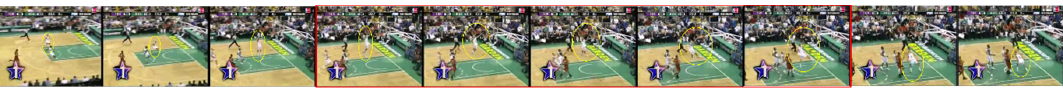
Figure 2. The change in frames in a “basketball dunk” over time. The yellow circles mark the changes in action, and several discriminative frames are outlined in red.